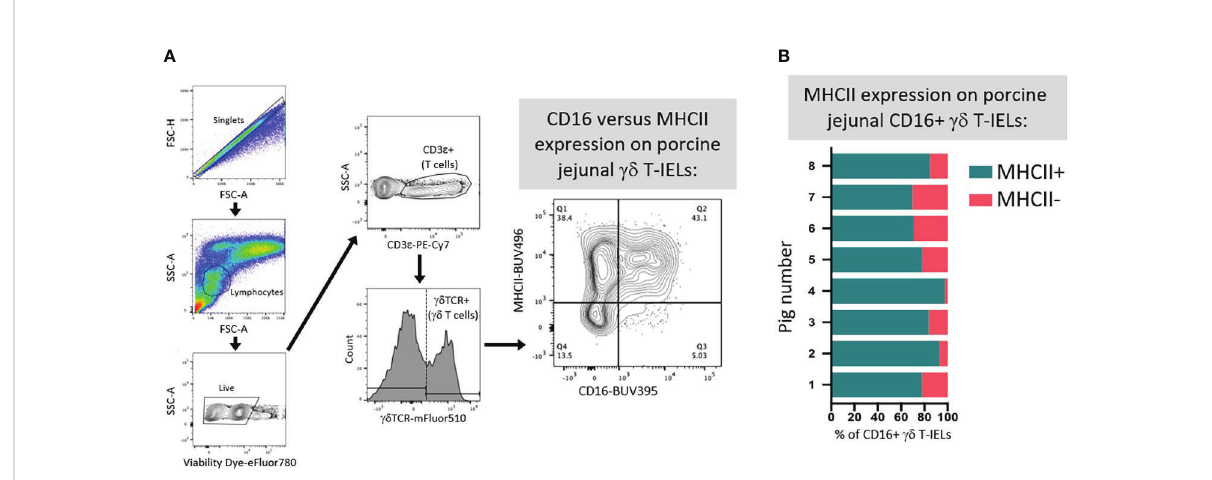
FIGURE 5 Co-expression of CD16 and MHC-II on gd T-IELs in porcine jejunum. (A) Representative fl ow cytometry gating showing the expression of CD16 and MHC-II on gated gd T-IELs in epithelial-enriched cell fractions from jejunum of a 6-week-old pig. (B) Stacked bar plot of the percentage of CD16 + gd T-IELs that are MHC-II + (turquoise) versus MHC-II - (salmon). Data are derived from jejunum of eight 6-week-old pigs. Epithelial- enriched cell fractions were isolated from jejunum and stained for fl ow cytometry as previously described (67). Detection reagents used for fl ow cytometry staining are as follows: Fixable Viability Dye eFluor780 (ThermoFisher Scienti fi c 65-0865-14); anti-CD3 e -PE-Cy7 (clone BB23-8E6- 8C8; BD 561477); anti- gd TCR (clone PGBL22A; Washington State University PG2032; conjugated to mFluor510 fl uorophore by Caprico Biotechnologies); anti-CD16 (clone G7; BioRad MCA1971GA) detected with anti-mouse IgG1 (clone A85-1; BD 740234); MHC-II (clone 2E9/13; BioRad MCA2314GA) detected with anti-mouse IgG2b-BUV496 (clone R12-3; BD 750517). FSC-A (forward-scatter area); FSC-H (forward-scatter height); Ig (immunoglobulin); MHC (major histocompatibility complex); SSC-A (side-scatter area); T-IEL (intraepithelial T lymphocyte); TCR (T cell